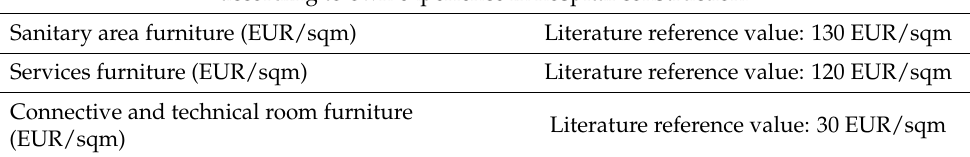
Table A6. Furniture cost. In this section, it is required to insert a value in EUR/sqm for some sanitary furniture functions, according to own experience in hospital